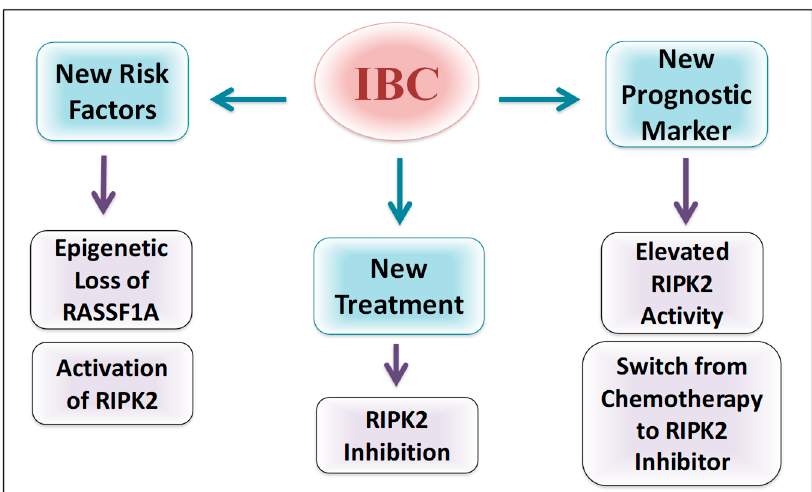
Figure 8. Potential importance of RIPK2 in IBC. IBC cell line and patient samples reveal elevated levels of active RIPK2 that may be linked to epigenetic silencing of RASSF1A. Loss of RASSF1A, therefore,